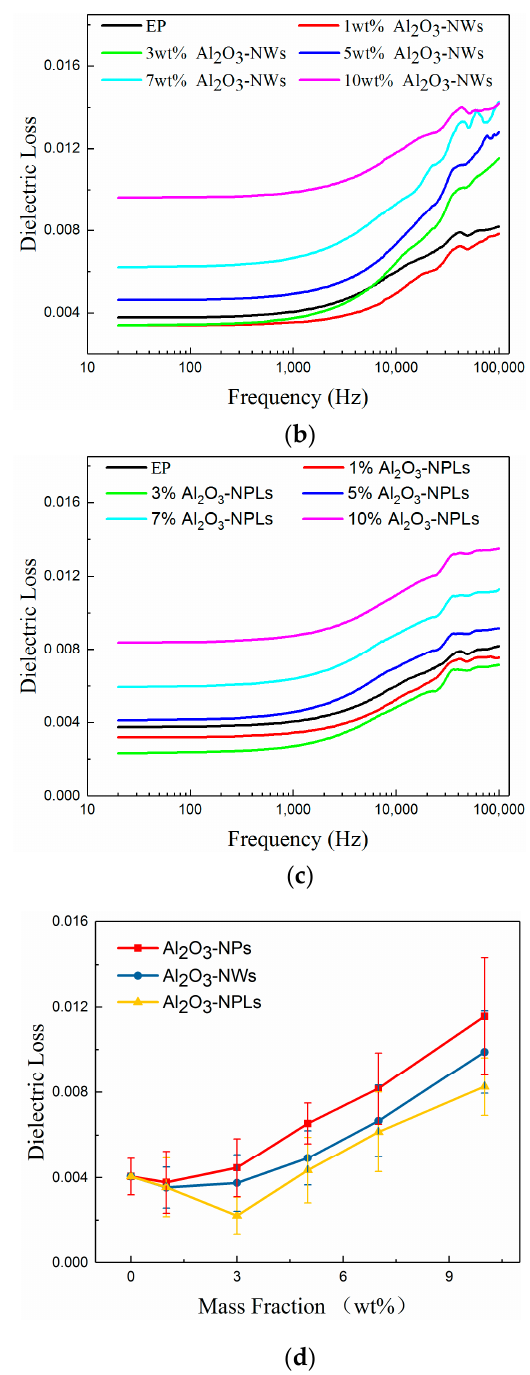
Figure 8. Change in the dielectric losses of the composites with different mass fractions of Al 2 O 3 nano-fillers with frequency: ( a ) Al 2 O 3 -NPs, ( b ) Al 2 O 3 -NWs, ( c ) Al 2 O 3 -NPLs, and ( d ) dielectric losses of the composites as a function of filler content measured at room temperature and 1 kHz.